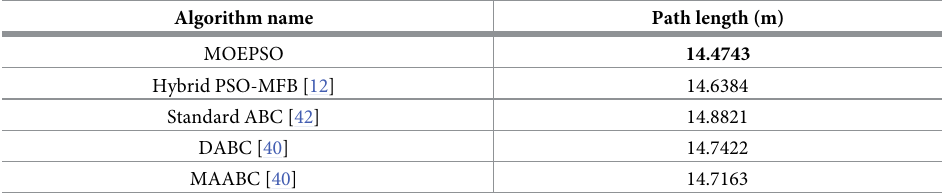
Table 10. Path planning results in the static environment (6